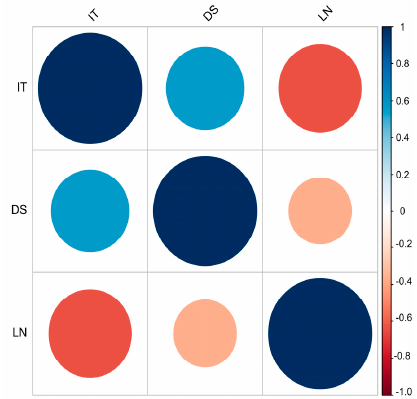
Figure 5. Pearson correlations between the disease parameters infection type (IT), disease severity (DS), and leaf necrosis (LN) assessed for yellow rust at the first leaf at the seedling stage. Coefficients > |0.18| are significant ( p < 0.05).